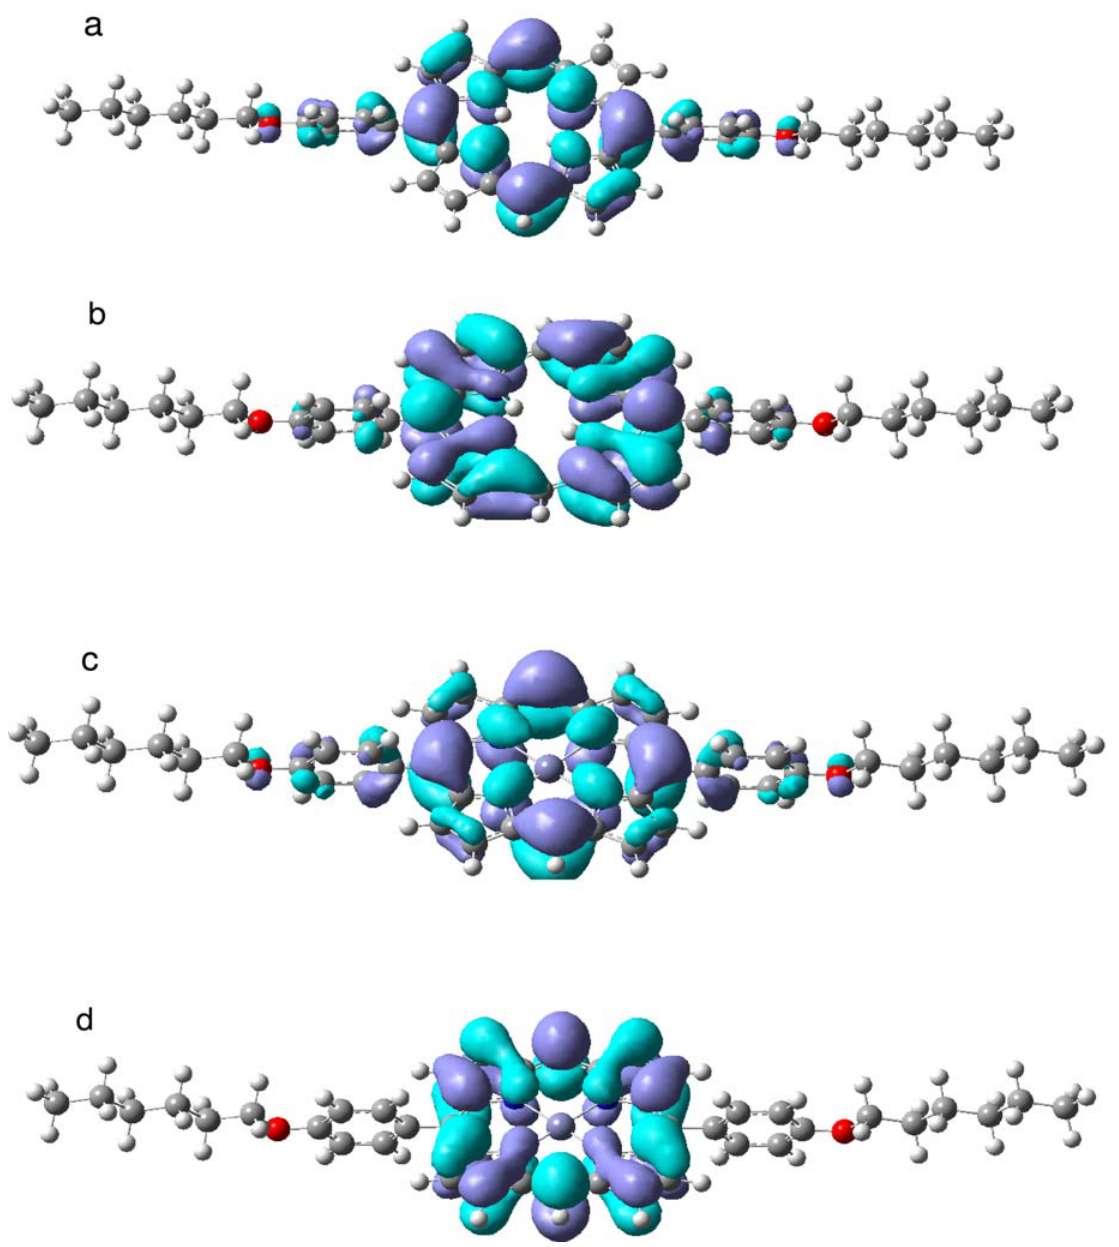
Figure 8. HOMO and LUMO molecular orbitals of compound 2 and 5 : a) HOMO of 2 ; b) LUMO of 2 ; c) HOMO of 5 ; d) LUMO of 5